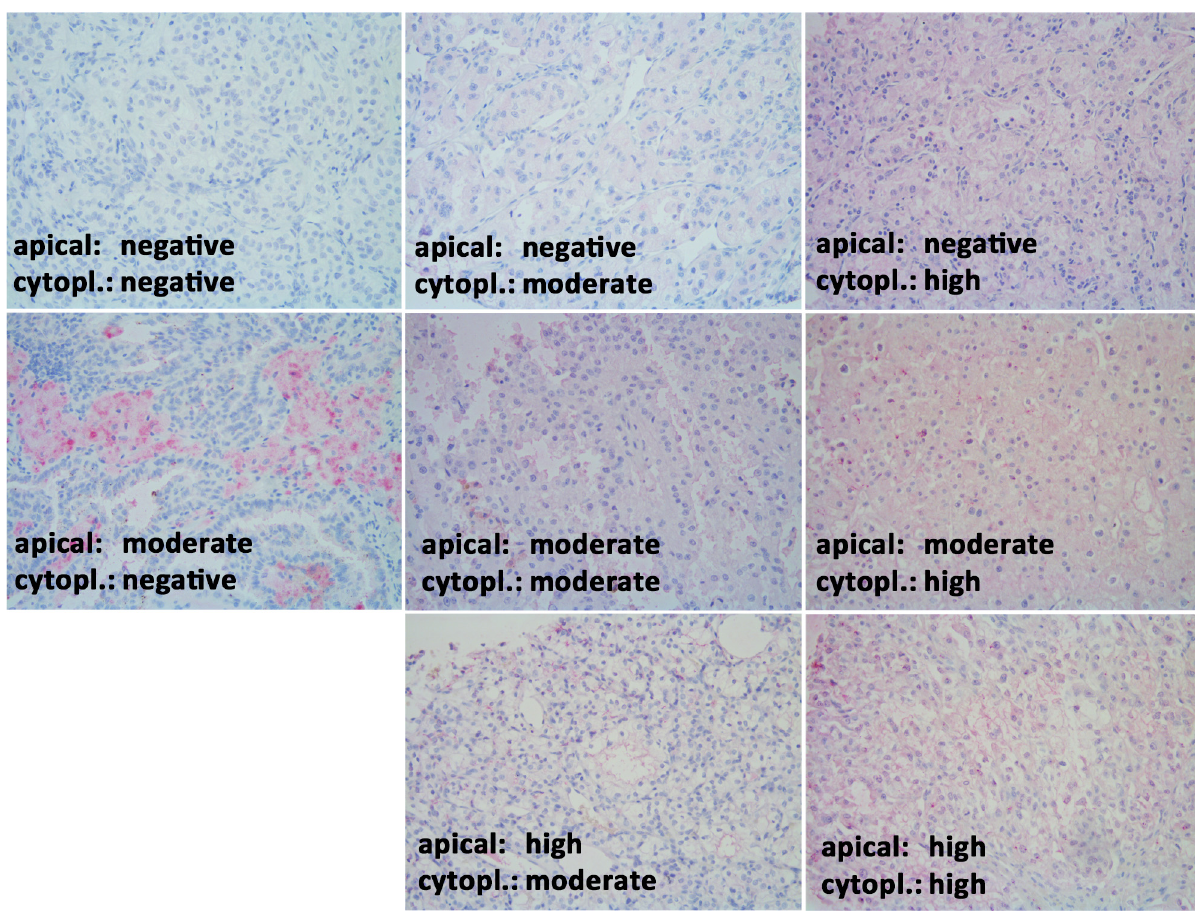
Fig 6. LOX expression in tissue of ccRCC. Apical and cytoplasmic staining were separately scaled in negative, moderately positive or highly positive. There was no tumor with high apical and negative cytoplasmic staining. Magnification: 200x.